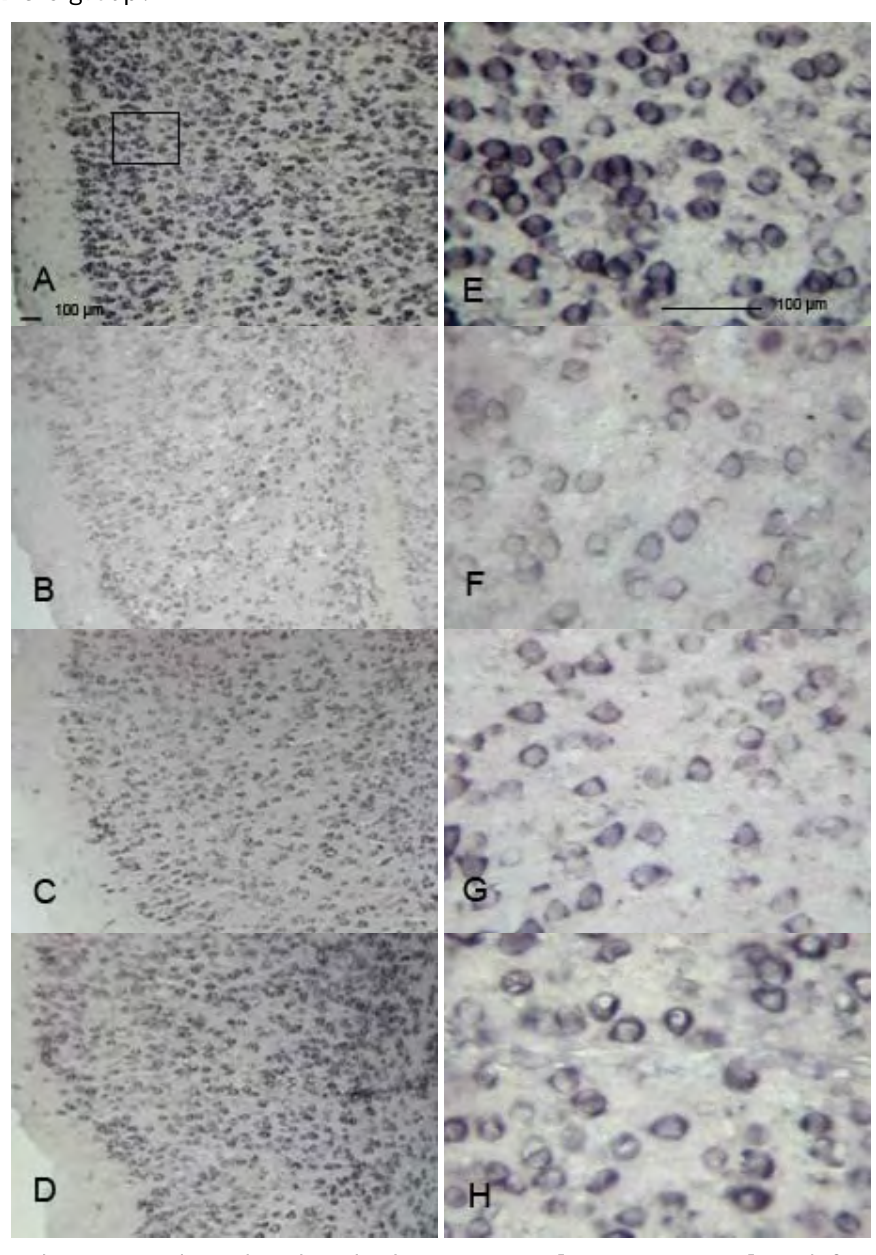
Figure 5 . Effects of daidzein on the expression levels of bax mRNA assessed by non-radioactive in situ hybridization in D-gal-treated mice cortexes. (A) Aging control. (B) Vehicle control. (C) Da-10 group. (D) Da-5